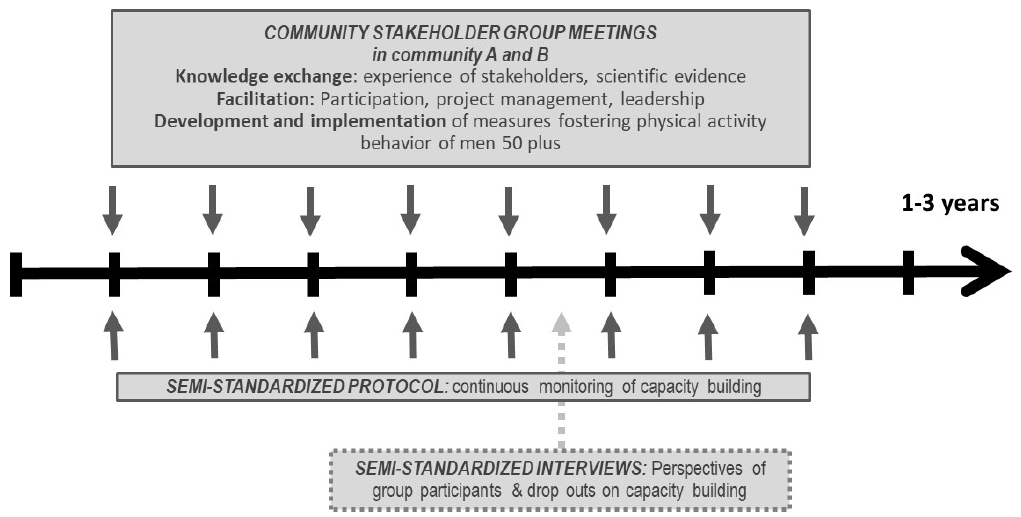
Figure 1. Capacity building and evaluation in ACTION4men.